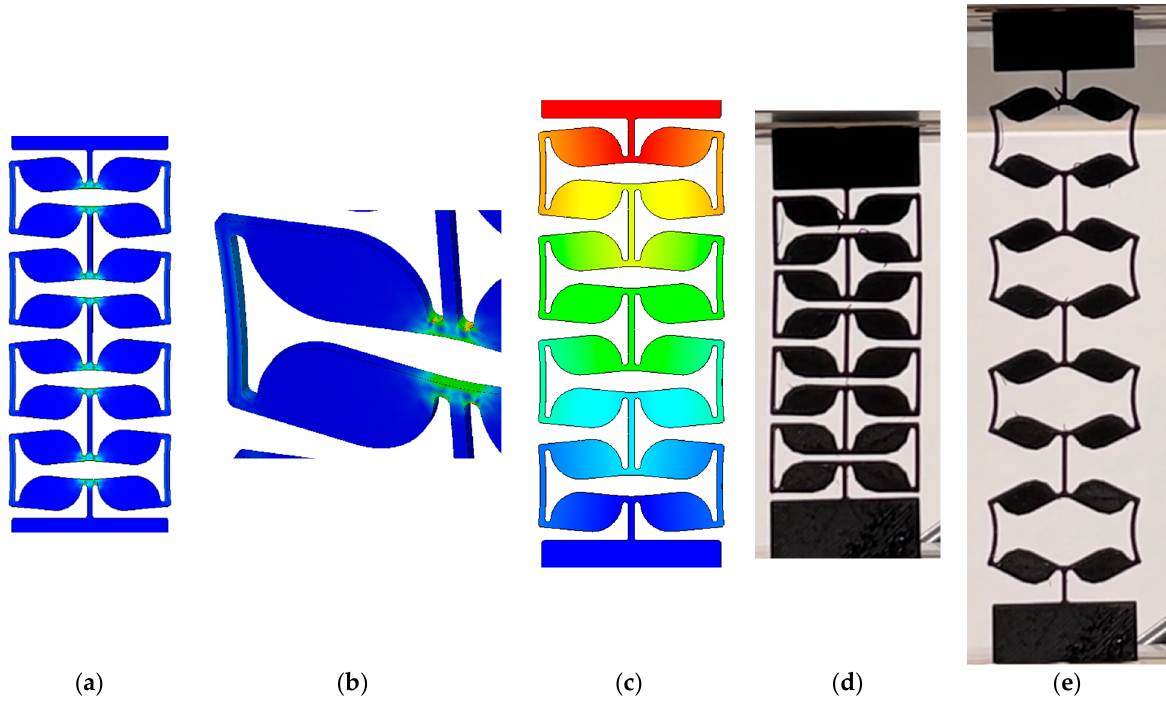
Figure 10. KD structure with FEA, unstretched length, and stretched length: ( a ) FEA stress analysis, ( b ) FEA close-up for stress concentration, ( c ) FEA displacement, ( d ) printed structure, ( e ) stretched printed structure.